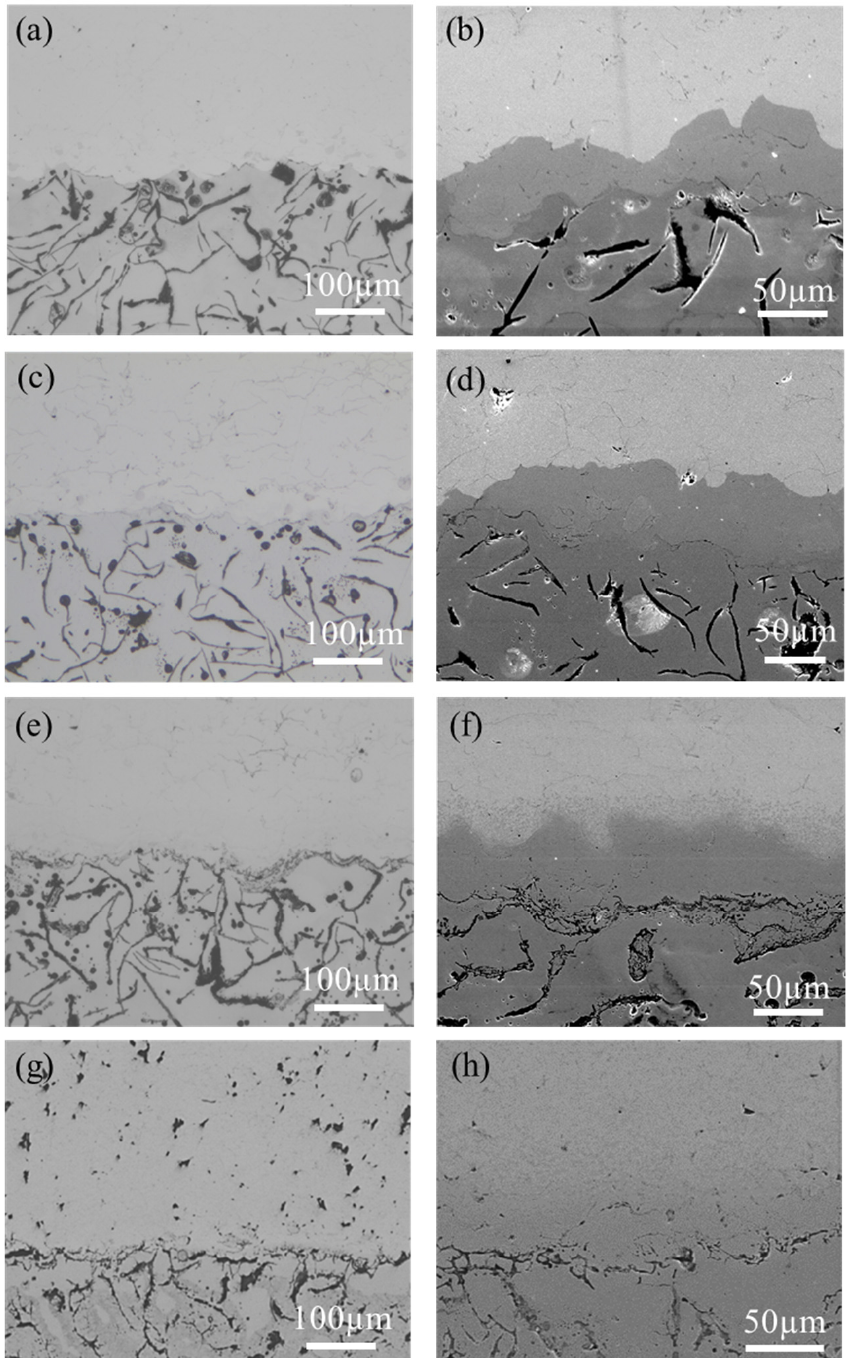
Figure 4. Optical ( a , c , e , g ) and SEM ( b , d , f , h ) micrographs of cold-sprayed IN625 coating on grey cast iron (GJL250) substrate at the interface for ( a , b ) 400-6, ( c , d ), 600-6, ( e , f ) 850-6 and ( g , h ) 1050-6. The description of the layers is shown in Figure 3b.